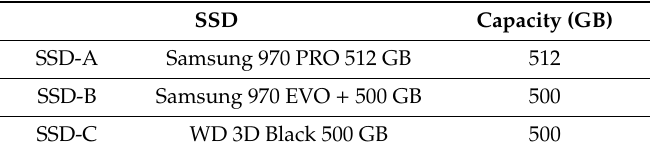
Table 2. Target solid-state drives (SSDs) used. Submission queue size and the number of submission queues are all 16,384 and 12, respectively.